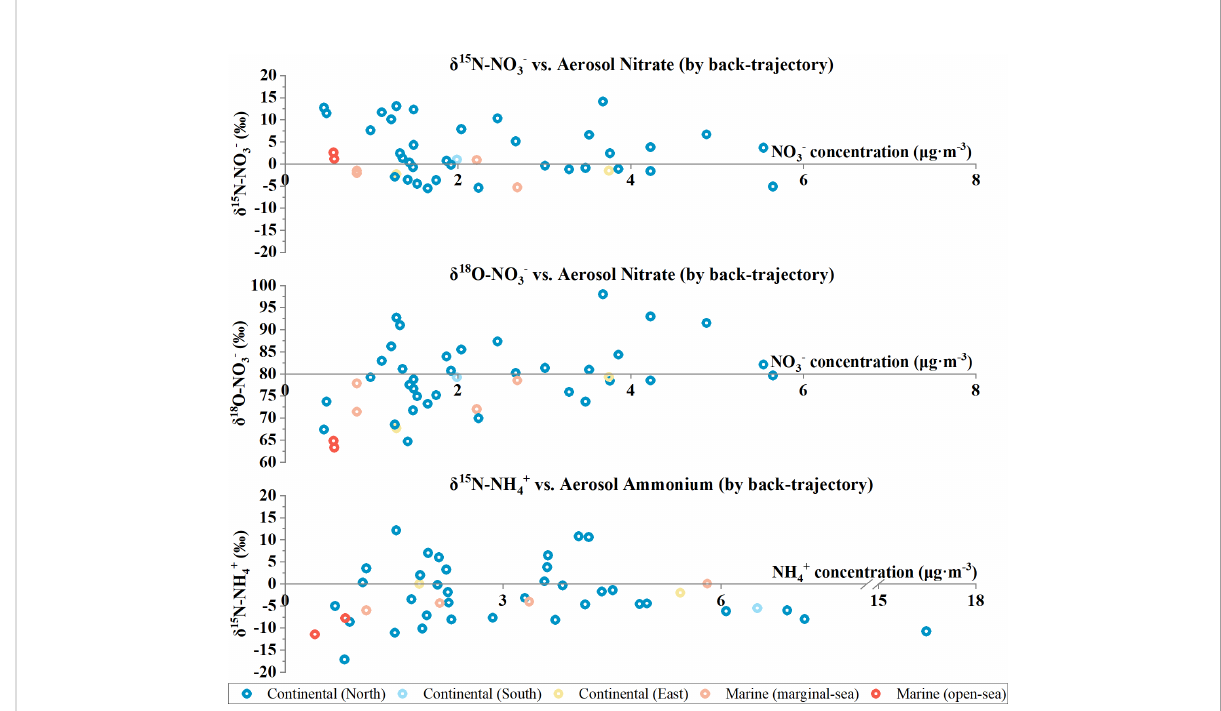
FIGURE 2 Aerosol nitrate and ammonium isotopic compositions plotted against aerosol nitrate and ammonium concentrations with samples coded based on the air-mass back trajectories at the Qianliyan Island in